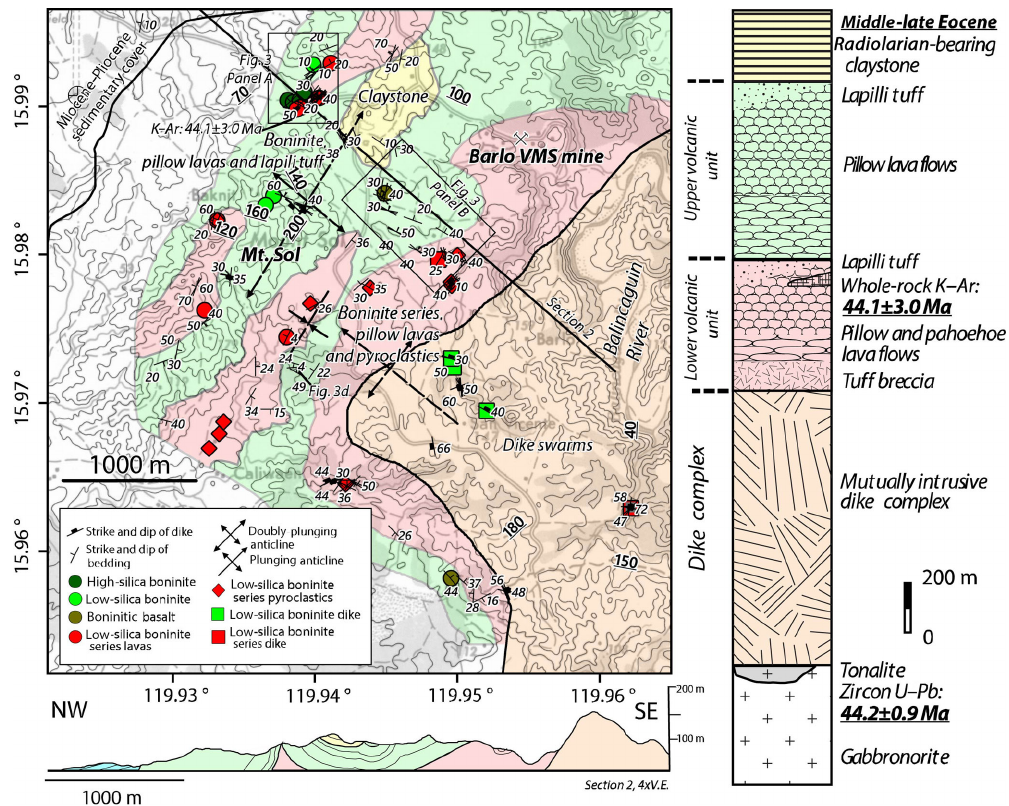
Figure 2. Geological map of Barlo and its environs. Closed symbols are samples with whole-rock geochemical data. Enclosed areas (panels A and B) are shown in Fig. 3. Geologic cross-section is given along a NW–SE section line. Geologic column shows stratigraphic relationships and estimated thickness of the upper and lower volcanic unit. Biostratigraphic, whole-rock K–Ar and zircon U–Pb ages are from Schweller et al. (1984), Fuller et al. (1989) and Encarnacion et al.